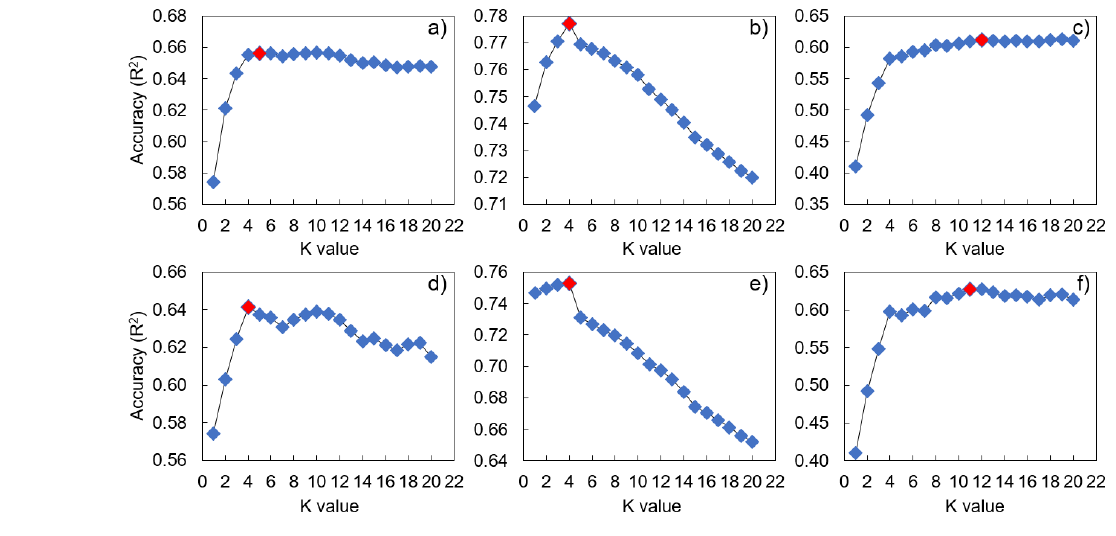
Figure 2. K-nearest neighbor (KNN) model performance according to hyperparameter values. ( a ) Manhattan distance, ( b ) Euclidean distance, ( c ) Chebyshev distance, ( d ) Manhattan uniform, ( e ) Euclidean uniform, and ( f ) Chebyshev uniform. The red diamond represents the hyperparameter value representing the optimal performance.